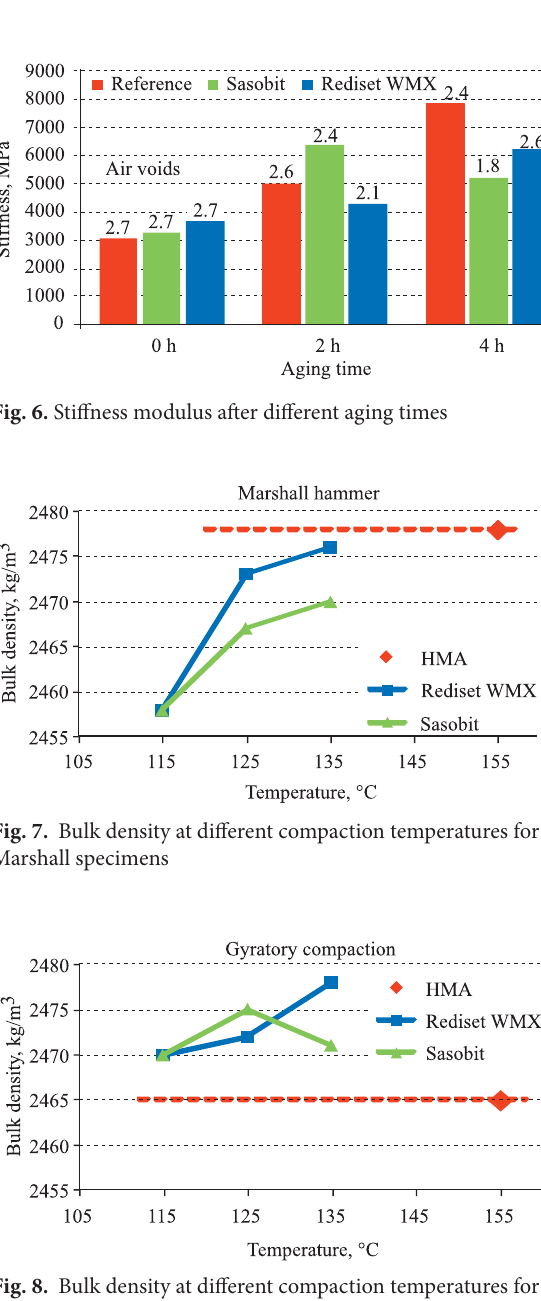
Fig. 8. Bulk density at different compaction temperatures for gyratory